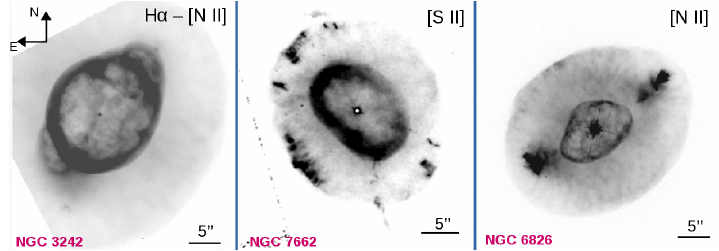
Figure 1. The HST images of some MSPNe. Note that the H α image of NGC 3242 was already corrected for the contamination of the nitrogen line